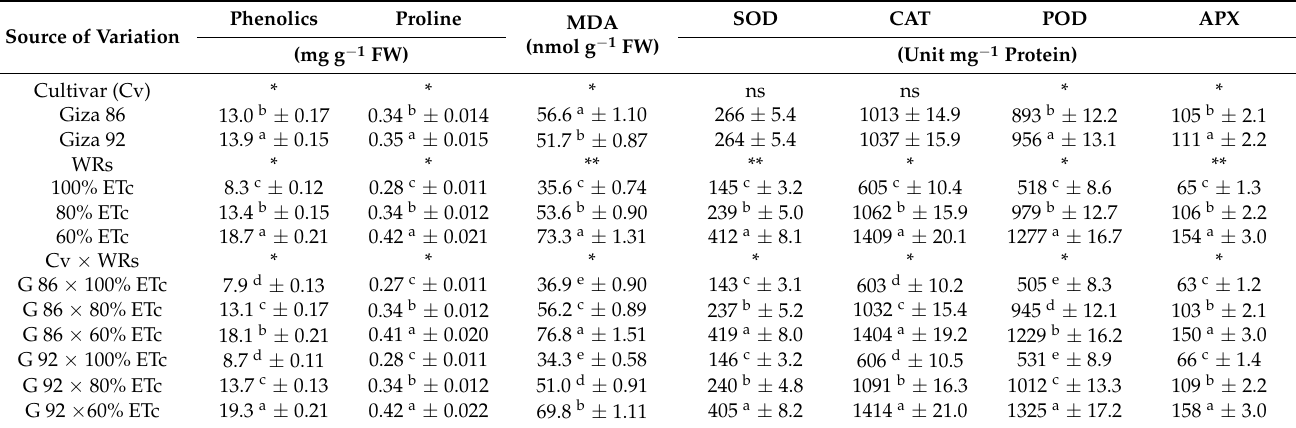
Values are means ( ± SE). * and ** indicate significant differences at p ≤ 0.05 and p ≤ 0.01 probability levels, respectively, and ns indicates non-significant differences. Means followed by different lowercase letters